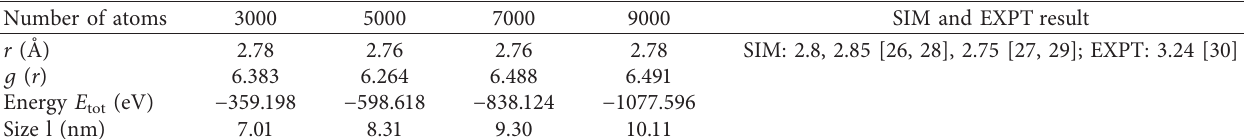
Table 2: First peak’s position and height of radial distribution function for amorphous aluminium with different numbers of atoms. Number of atoms 3000 5000 7000 9000 SIM and EXPT